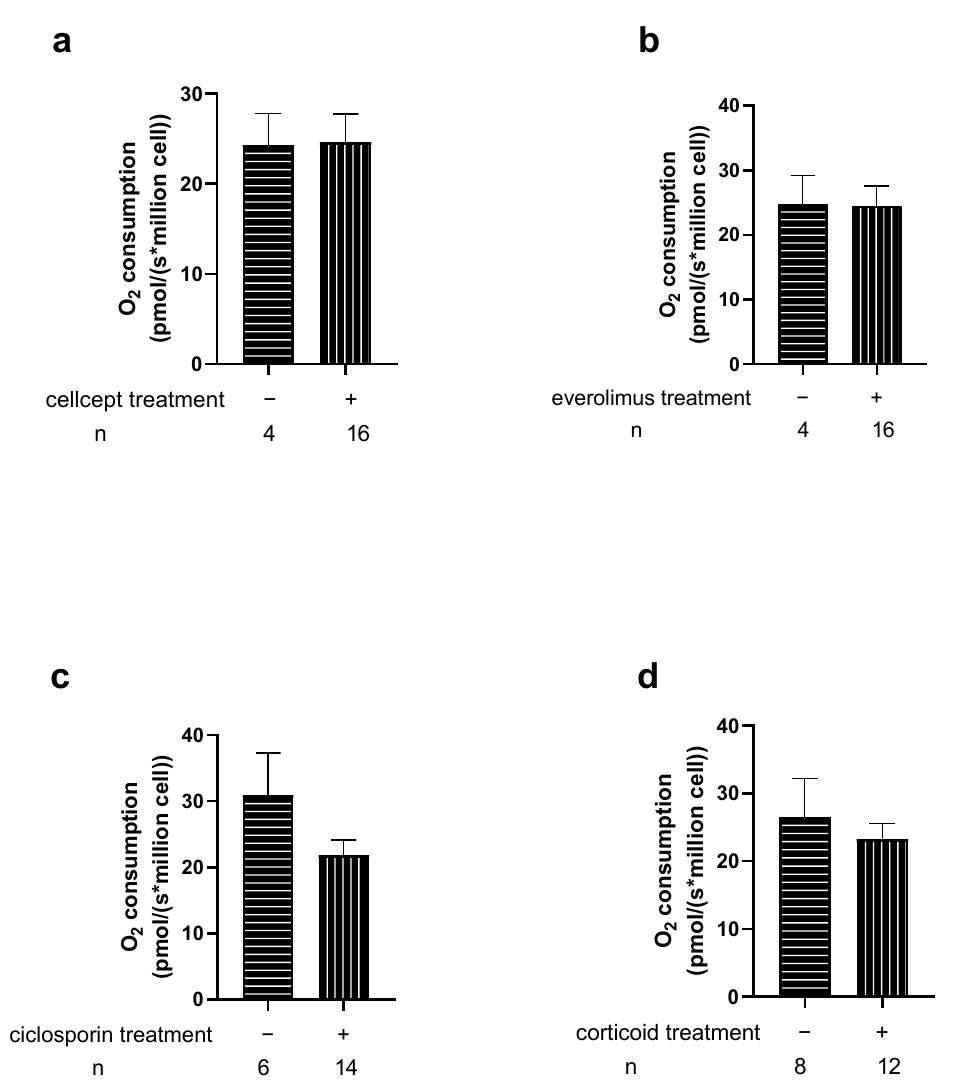
Figure 8. Effects of immunosuppressive therapies on transplant patients PBMCs mitochondrial respiration by complex IV (OXPHOS CIV). − /+ represents the group without or with specific treatment. n: number of patients in each group. Values are means ± SEM. ( a ) Cellcept. ( b ) Everolimus ( c ) Ciclosporin ( d ) Corticoid.